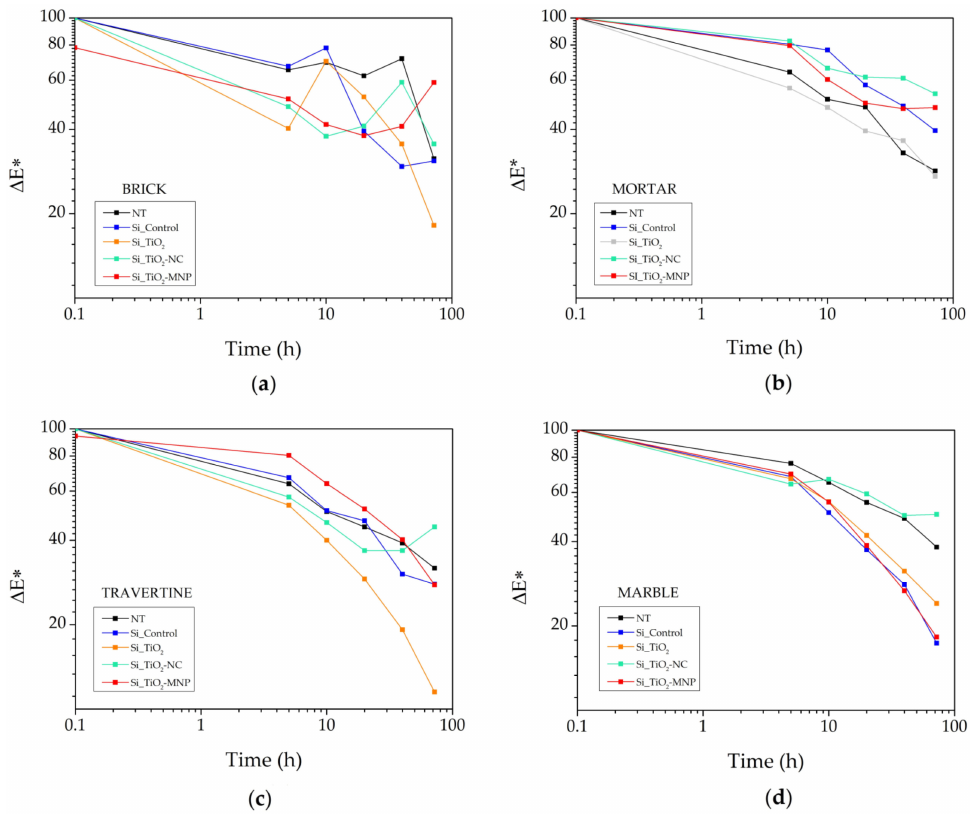
Figure 6. ∆ E * variation connected to the discoloration of treated and untreated stones previously stained with methyl orange and then irradiated with UV light for 72 h: ( a ) brick, ( b ) mortar, ( c ) travertine and ( d ) Carrara